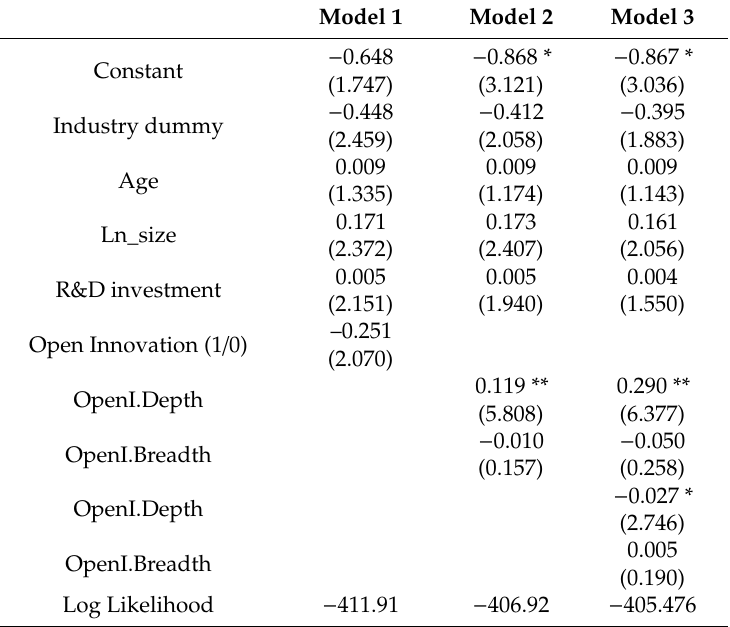
Table 4. Logistic regression on the ambidextrous innovation